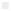
COSMO-RS predictions versus reported experimental values of CO2 solubility in DESs.CO2 solubility at total pressures of (■) P < 5 bar, (▲) P = 5–9 bar, (●) P > 9 bar and (….) identity line y = x.